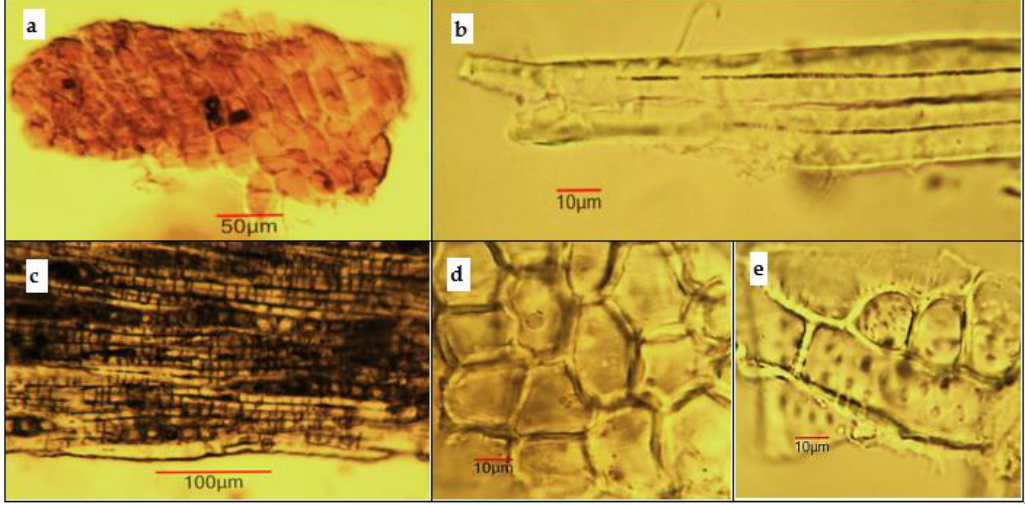
Figure 4. Microphotos of powdered stem bark samples of Koelreuteria paniculata : ( a ) cork on surface view; ( b ) isolated phloem fiber bundle; ( c ) fibers with a sheath of calcium oxalate; ( d ) parenchymal cells on surface view; ( e ) rectangular sclereids.